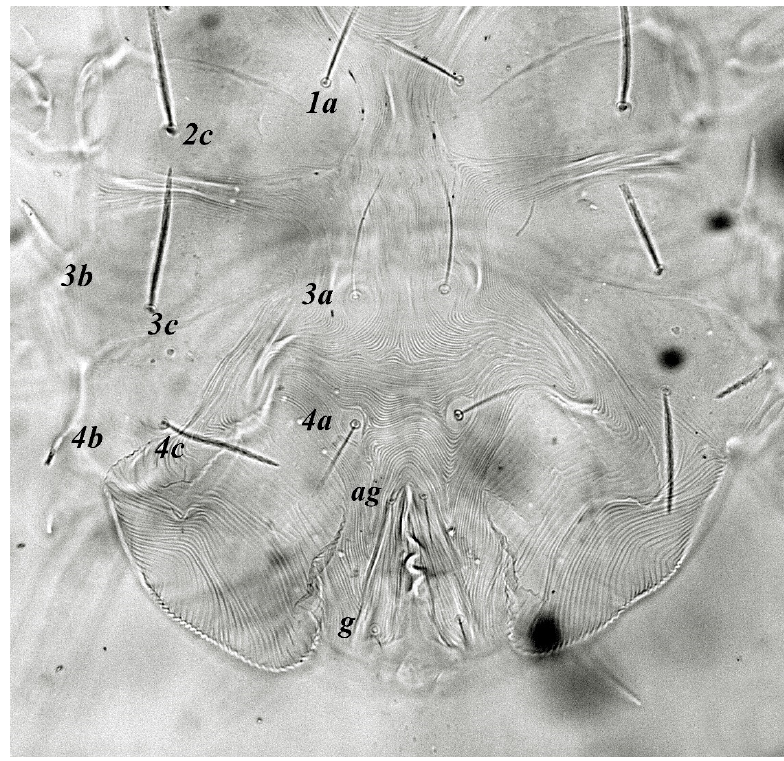
Figure 29. Neophyllobius denizliensis . Female. Venter.